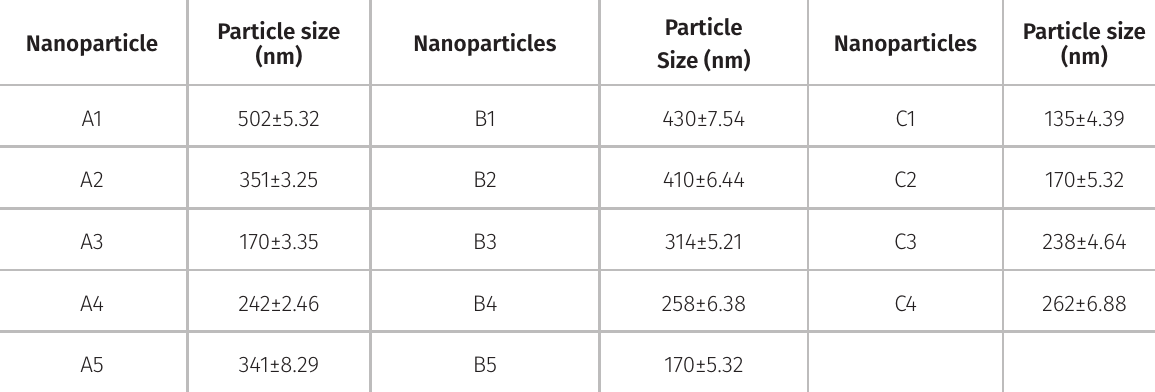
Table I. The particle sizes of different